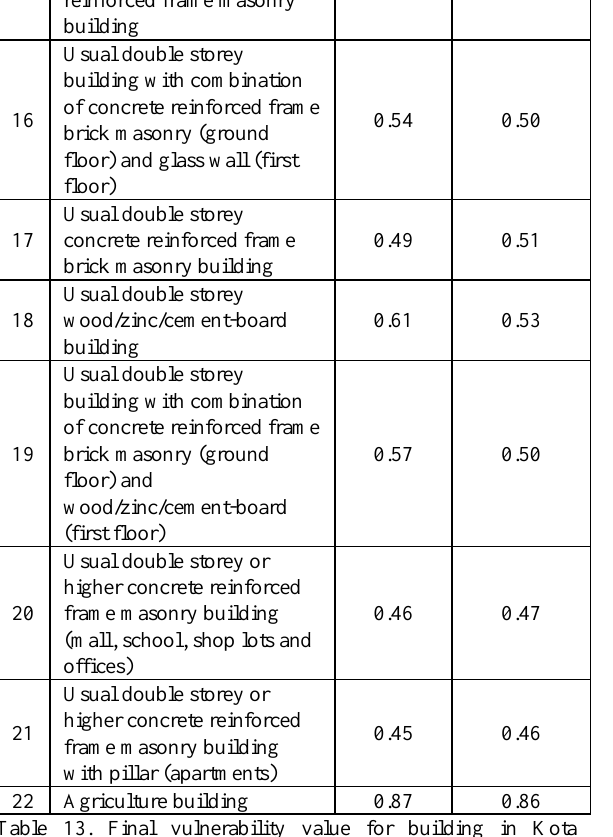
Figure 10. Vulnerability map for